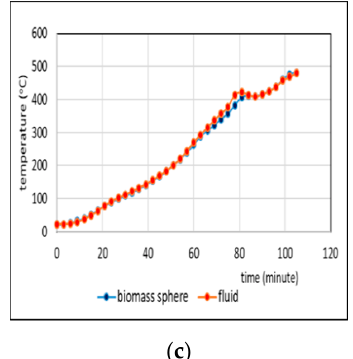
Figure 7. Comparison of temperatures of biomass spheres and co-pyrolysis fluid. Co-pyrolysis used a feed containing 50% weight of PP: ( a ) Thermocouple #3, ( b ) Thermocouple #4, ( c ) Thermocouple #5.